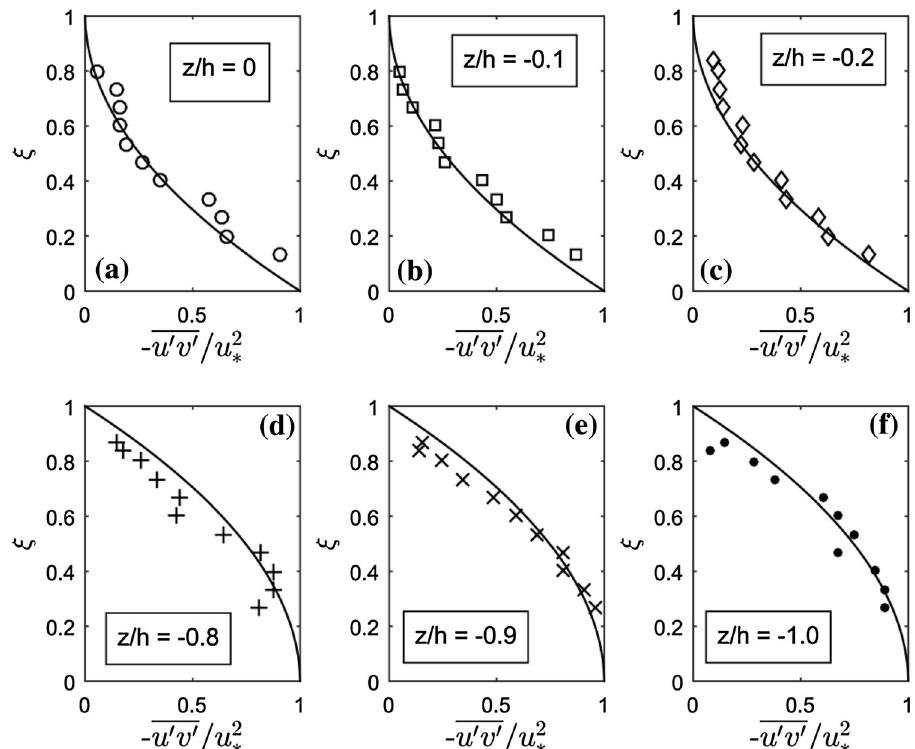
Fig. 6 Prediction of total shear stress by Eq. (13) using proposed